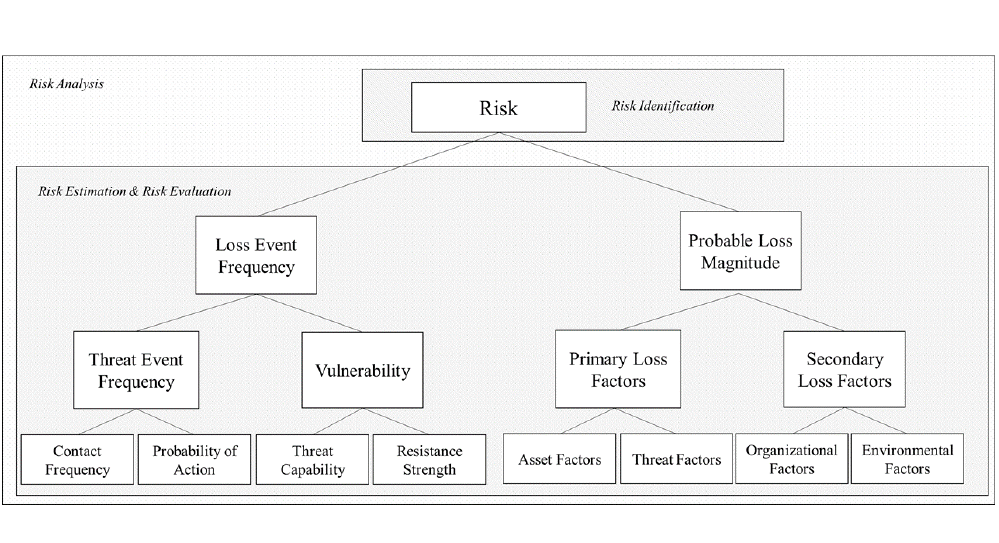
Figure 2. The FAIR (Factor Analysis of Information Risk) Model assesses the organization’s risk by factoring in the Loss Event Frequency (LEF) and Loss Magnitude